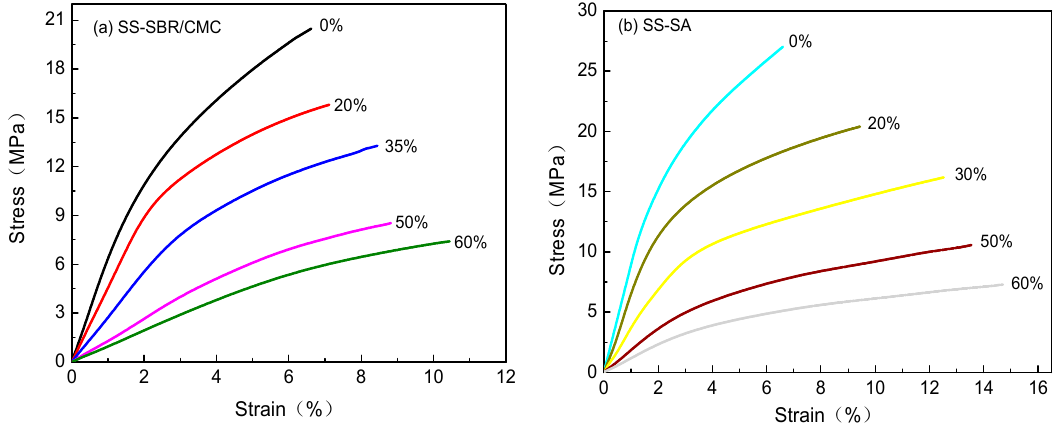
Figure 1. E ff ects of carbon black (SS) content on the tensile stress-strain curves of cured conductive composites (BCC) films.